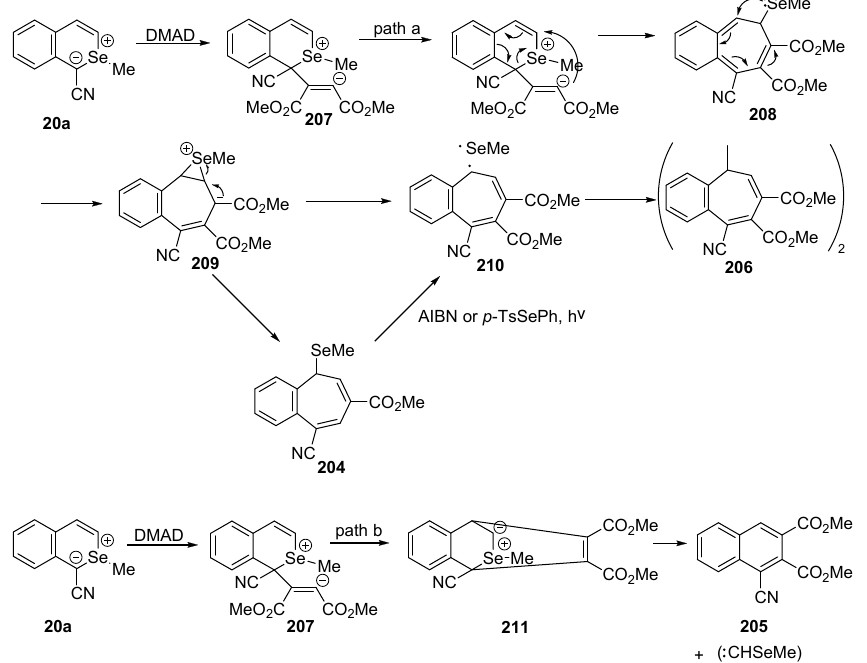
Scheme 65. Reaction of selenanaphthalene 20a with methyl